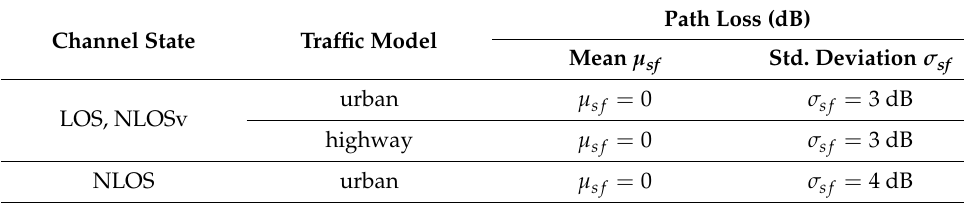
Table 2. Shadow fading model parameters for V2X system